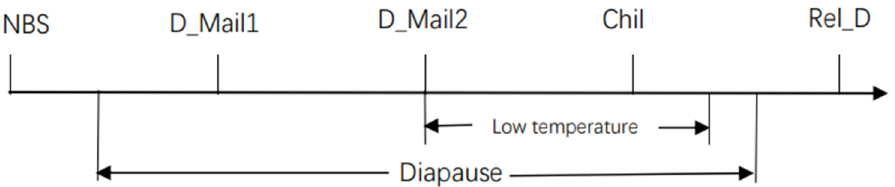
Figure 1. Schematic depiction of experimental design. NBS was sampled on the first day using L:D = 12:12. Both samples were in the diapause stage during diapause and low-temperature treatment at 4 °C. Rel_D is the sample after diapause is released. The exact time of the start and end of diapause is not certain, and the start and end of diapause marked on the picture is an estimate.